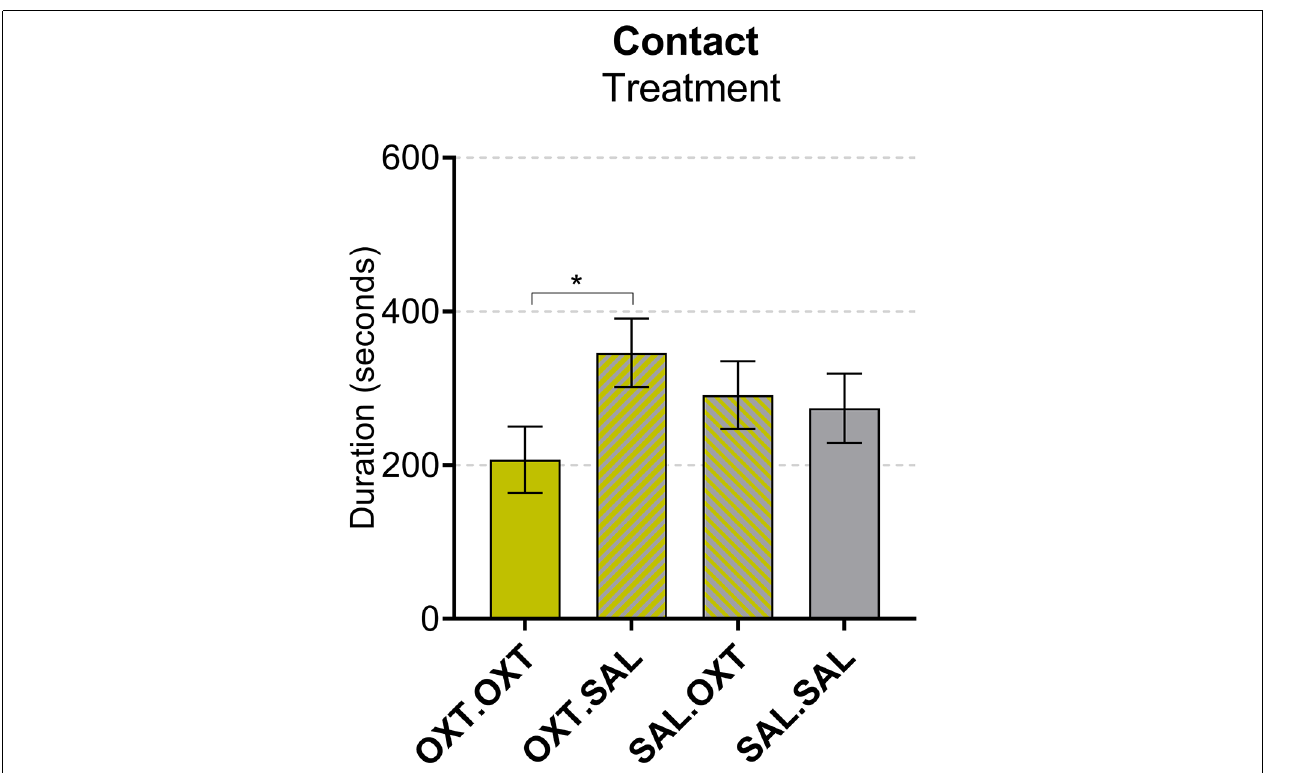
FIGURE 4 | Contact during reunion. Subjects treated with chronic OXT and acute OXT spent less time in contact with their pair mate following reunion compared to subjects that received chronic OXT and acute SAL. Significance summary: * p <